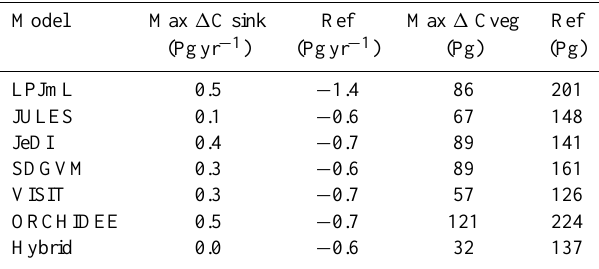
Table 6. Maximal loss of carbon sinks and the vegetation carbon stock as estimated for the illustrative LU change scenario (based on coloured lines in panel (a) and (b) of Fig. 4). The maximum of the transient changes (column 2 and 4) is compared to mean values of the C fluxes and the C stock averaged over the reference period 1980–2010 (column 3 and